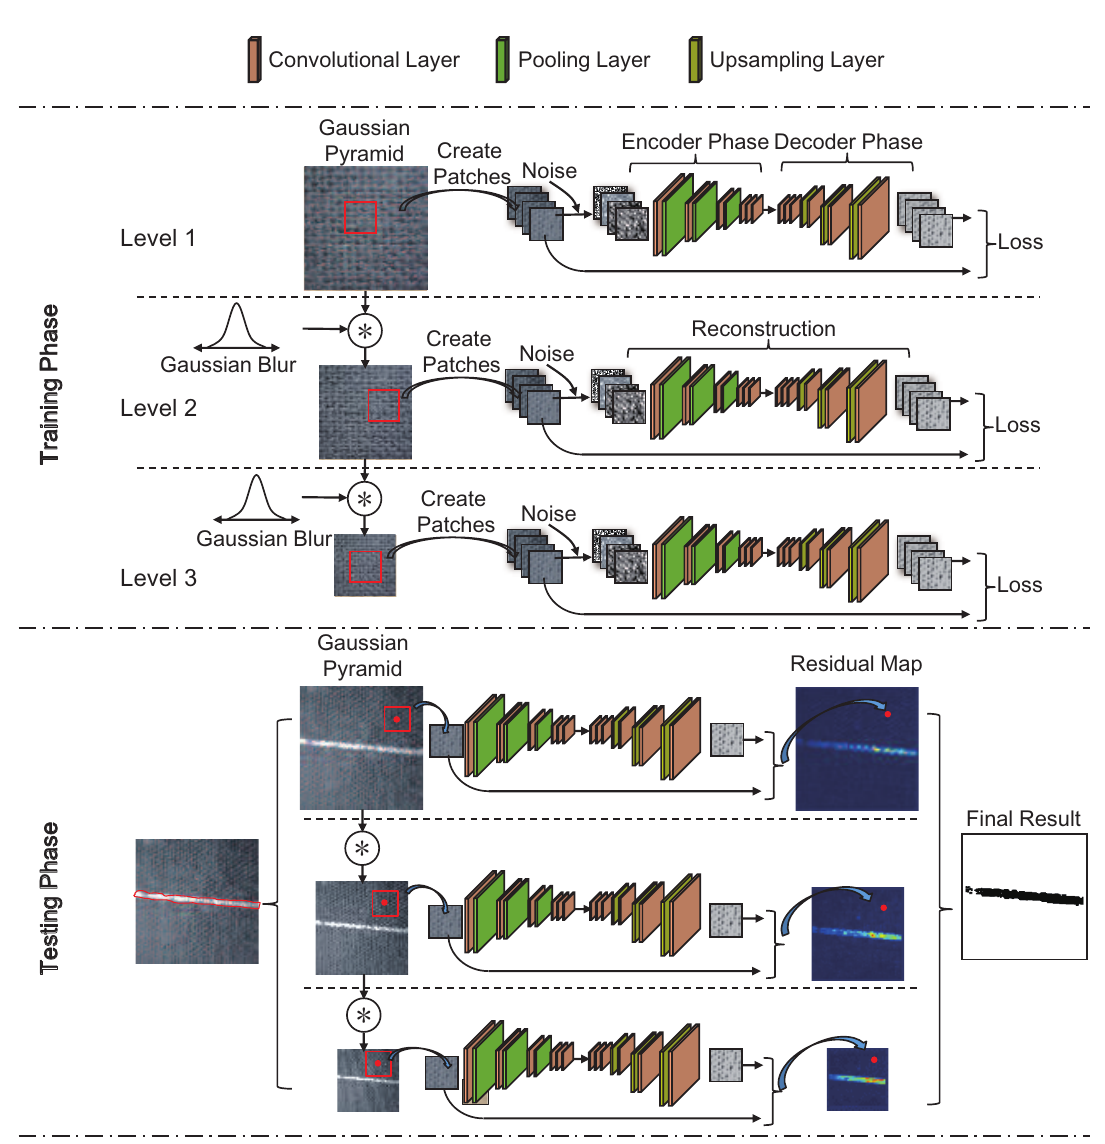
Figure 6. Overall architecture of the proposed MSCDAE